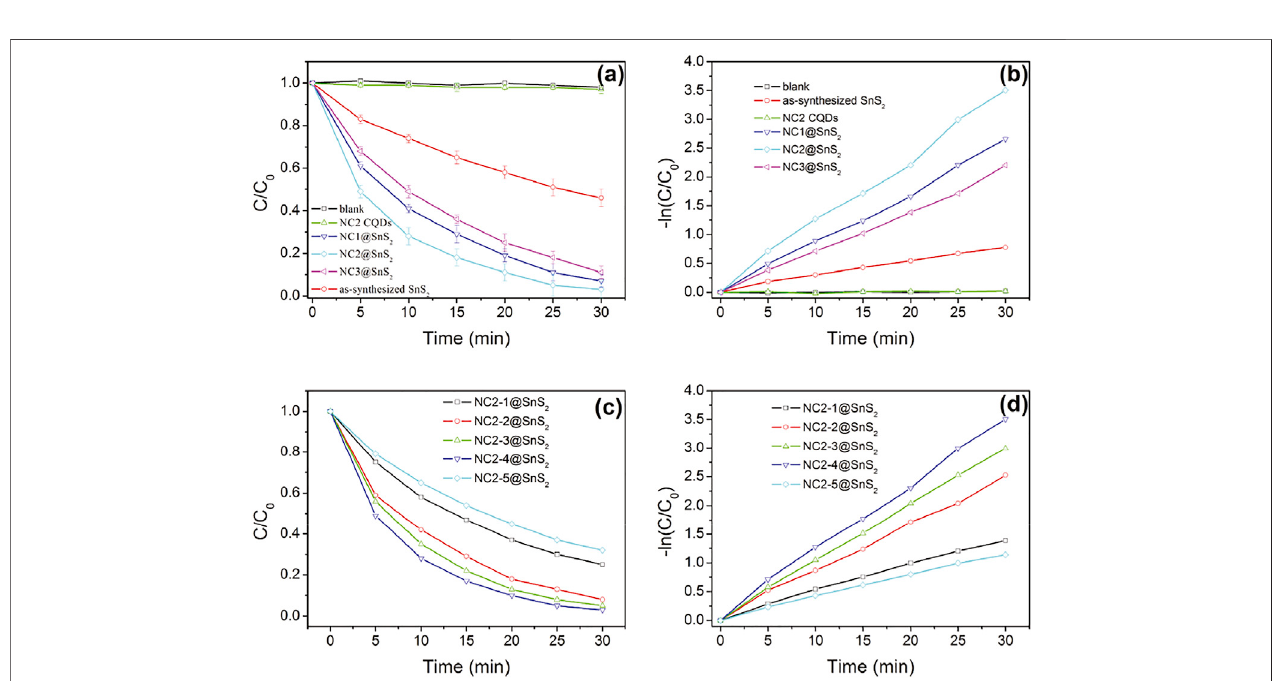
FIGURE5| C/C 0 and – ln(C/C 0 )valuesofCr(VI)solutionuponthepresenceoffollowingphotocatalysts:blank,NC2CQDs,as-synthesizedSnS 2 nanoparticles,and NC@SnS 2